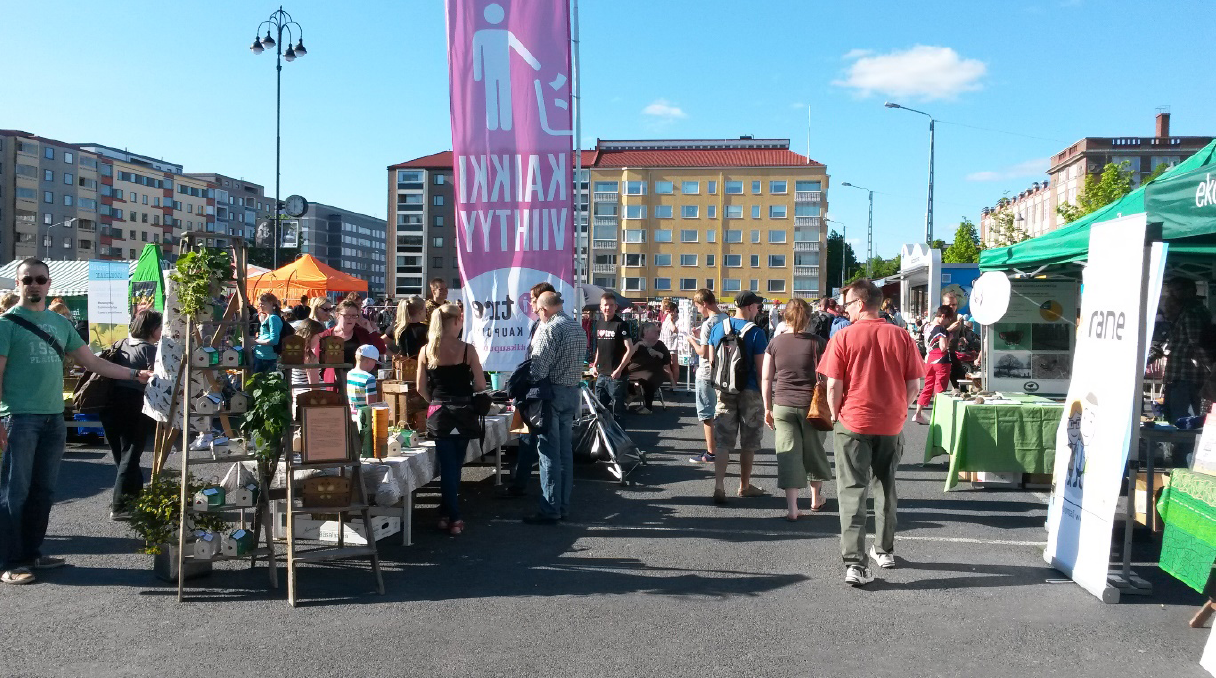
Figure 2. A view of Tammela’s market place on 1 June 2014. Photo by Minna